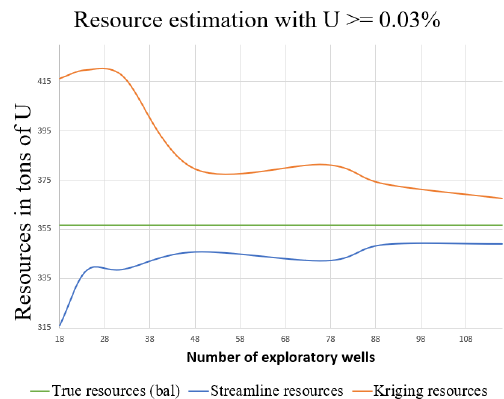
Figure 19. Comparison in resource estimation between streamline-based stochastic method and ordinary kriging for a synthetic deposit generated based on the data from a real deposit.